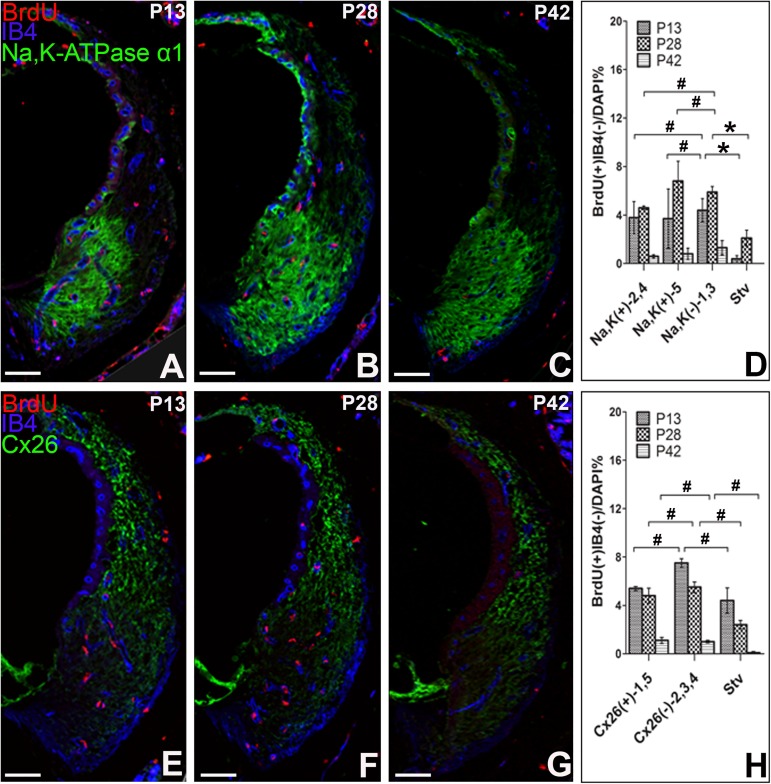
Distribution of BrdU+IB4- fibrocytes at Na,K-ATPase α1 or Cx26 positive area.Triple immunostaining for BrdU, IB4, Na,K-ATPase α1 (A-C) or Cx26 (E-F) were performed at P13, P28 and P42 after BrdU administration. The percentage of BrdU+IB4 cells was compared among Na,K-ATPase α1 positive area, Na,K-ATPase α1 negative area and Stv, or among Cx26 positive area, Cx26 negative area and Stv. #P>0.05, **P<0.01, *P<0.05. Scar bar = 100μm. (n = 3 per each group).